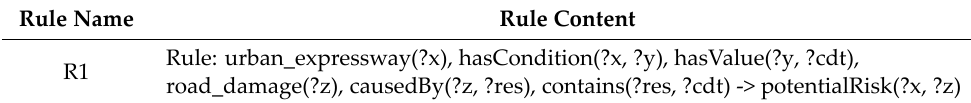
Table 5. Example of rules for matching potential risks of expressways.